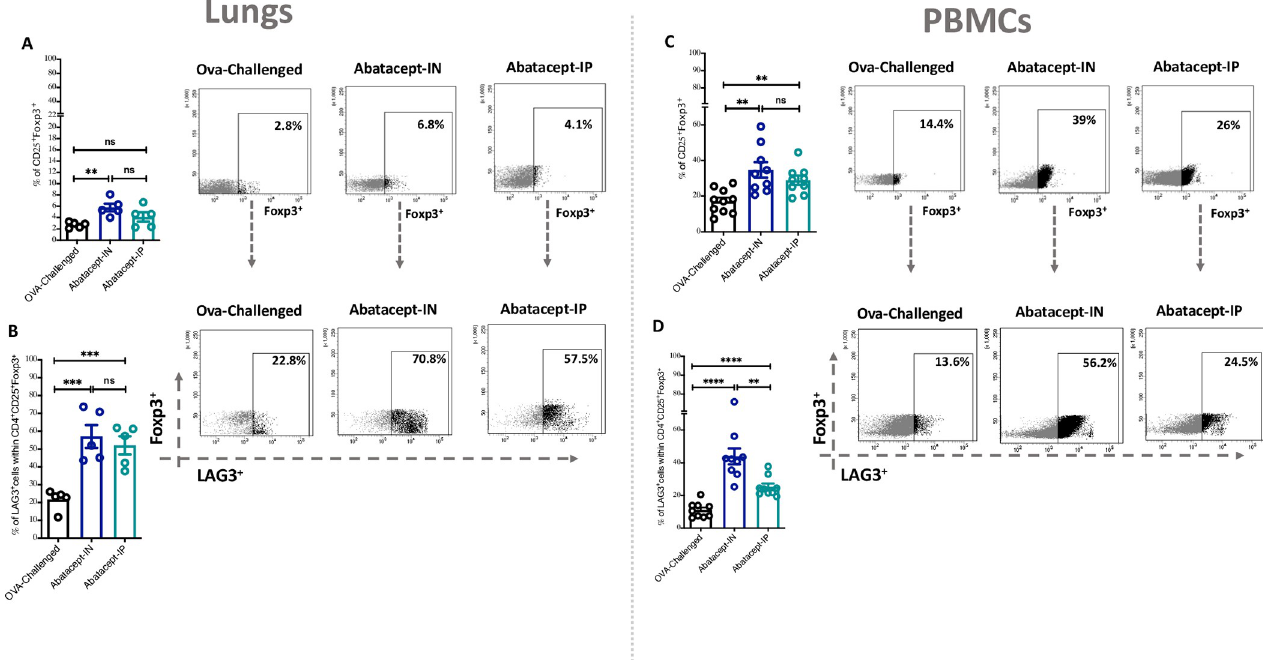
Fig 4. Abatacept enhances the levels of conventional Tregs (cTregs) in lung tissues and peripheral blood of OVA- sensitized mice. (A) Percentage of cTregs (Foxp3 + cells within CD4 + CD25 + ) in the lung tissues of abatacept IN, abatacept IP treated, or OVA challenged mice. (B) Percentage of LAG3 + cTregs (CD25 + Foxp3 + LAG3 + ) in the lung tissues of abatacept IN, abatacept IP treated, or OVA challenged mice. (C) Percentage of cTregs in the PBMCs of abatacept IN, abatacept IP treated, or OVA challenged mice. (D) Percentage of LAG3 + cTregs in the lung tissues of abatacept IN, abatacept IP treated, or OVA challenged mice. Lung tissues of 5 mice and PBMCs of 10 mice were used. Two-way unpaired t-test was used to calculate significance. � ��� P < 0.001. Events were recorded and analysed by using BD FACSDiva version 8.0.